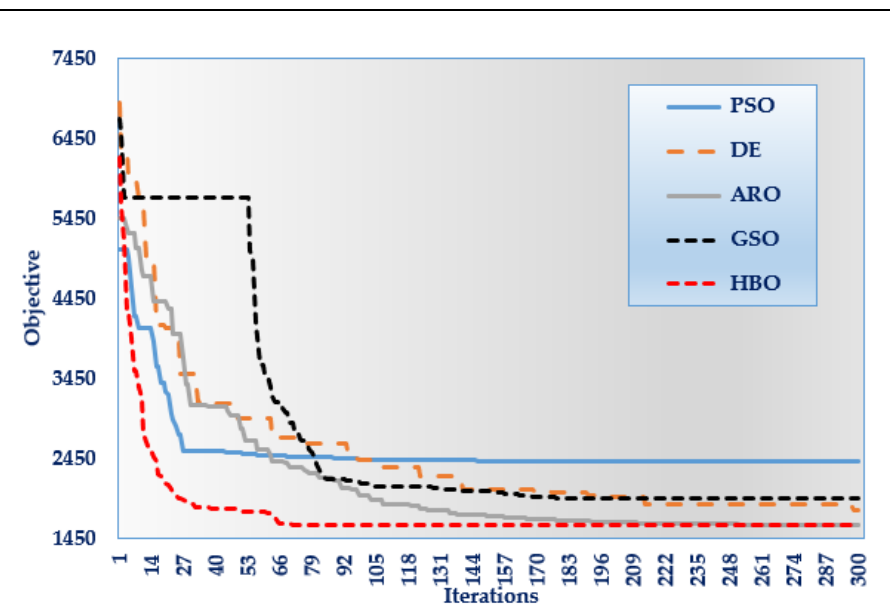
Figure 12. Convergence properties of the applied algorithms for IEEE 69-distribution feeder.